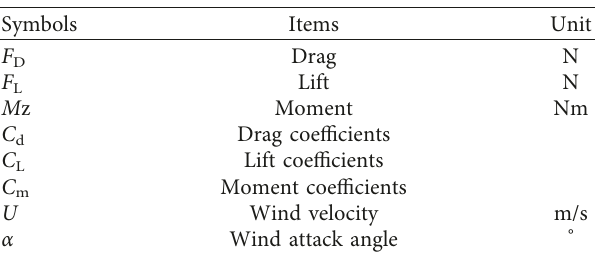
Table 1: Symbols and abbreviations.